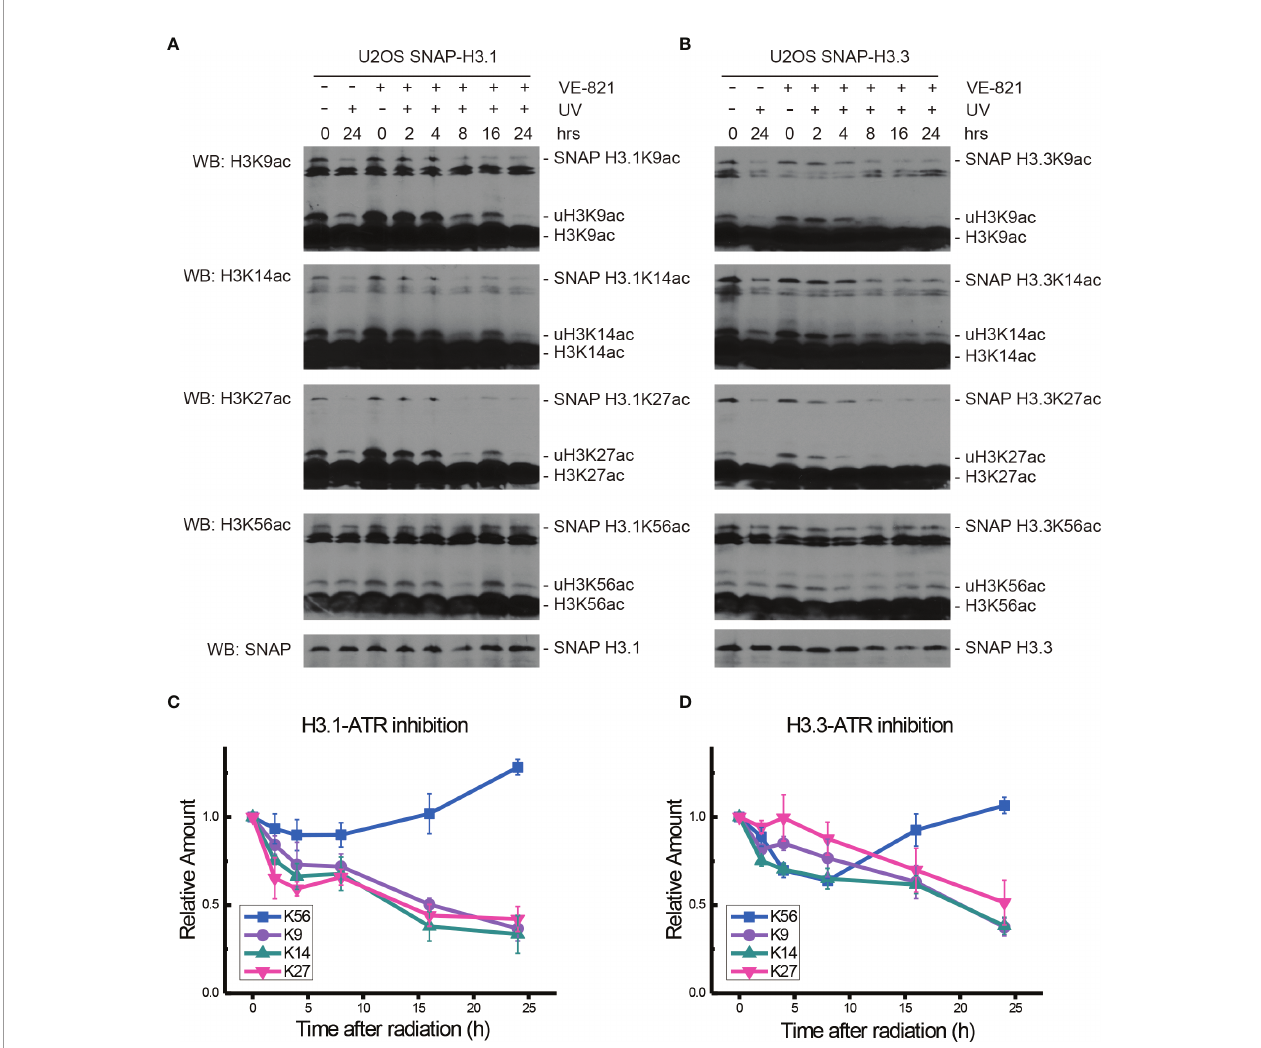
FIGURE 3 | Modulation of acetylated K9, K14, K27, and K56 of histone H3.1 or H3.3 by the ATR inhibitor VE-821 and UV radiation. (A) H3.1-SNAP U2OS cells were pretreated with DMSO (-) or VE-821 (+) for 1 h and then irradiated with 20 J/m 2 UV radiation. The insoluble nuclear protein samples were collected at 0 h, 2 h, 4 h, 8 h, 16 h, and 24 h after radiation. The acetylation levels of H3K9, H3K14, H3K27, and H3K56 were examined. SNAP-tagged histone H3 was used as an internal reference. (B) H3.3-SNAP U2OS cells were pretreated with DMSO or VE-821 and then irradiated with 20 J/m 2 UV radiation. The insoluble nuclear protein samples were collected, and the acetylation levels of H3K9, H3K14, H3K27, and H3K56 were examined. SNAP-tagged histone H3 was used as an internal reference. (C) Time-course alteration of acetylated K9, K14, K27, and K56 of histone H3.1 after 20 J/m 2 UV radiation and VE-821 treatment. The data are normalized immunoblotting results by ImageJ analysis from three separate experiments. (D) Time-course alteration of acetylated K9, K14, K27, and K56 of histone H3.3 after 20 J/m 2 UV radiation and VE-821 treatment. The data are normalized immunoblotting results by ImageJ analysis from three separate